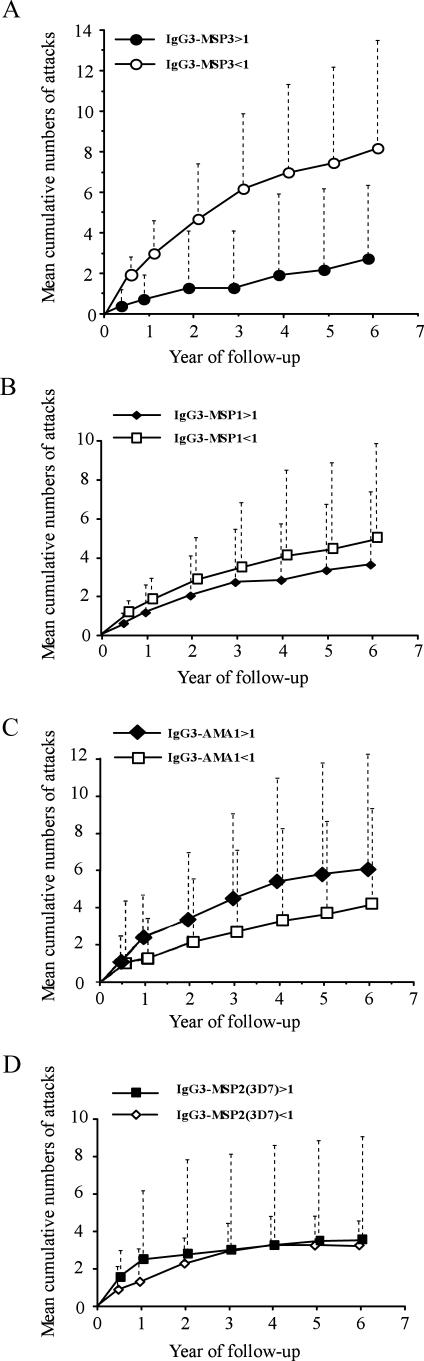
Mean Cumulative Number of Malaria Attacks Identified over Six Years of Follow-up in Dielmo, in Relation to IgG3 Antibodies to Each AntigenFor each antigen, specific IgG3 responses were dichotomized (antibody ratio less than or greater than 1) and in each group the occurrence of malaria attacks was calculated. To avoid the confounding effect of age, a subgroup of 49 children was selected for this analysis so that the mean age was similar (5.5 ± 2.6 y) among children with or without antibodies to each antigen. The mean cumulative numbers of malaria attacks are indicated for anti-MSP3b (A), anti-MSP1 (B), anti-AMA1 (C), and anti-MSP2-3D7 (D) IgG3 responses with ratio values less than 1 (open circles) or greater than 1 (closed circles). Error bars indicate SD.